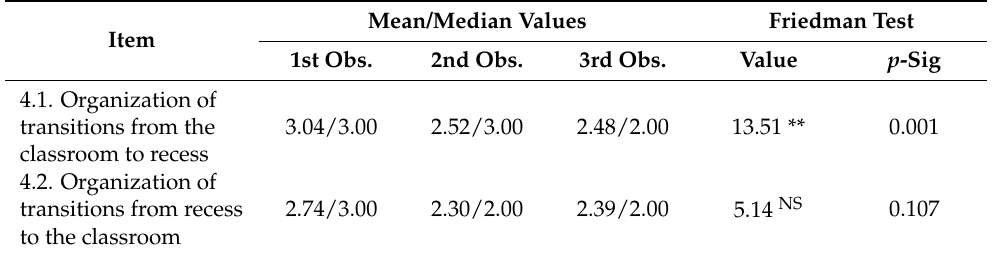
Table 4. Comparative analysis of observations. Items from D4: Transitions. GRF-OT.Cat. n = 23 schools.